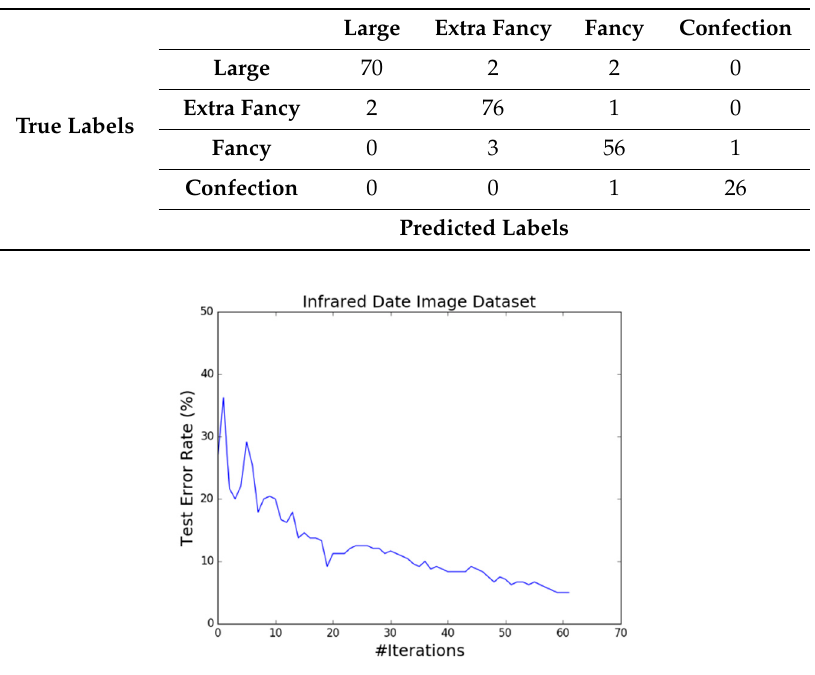
Figure 9. Classification performance over the course of the learning process.